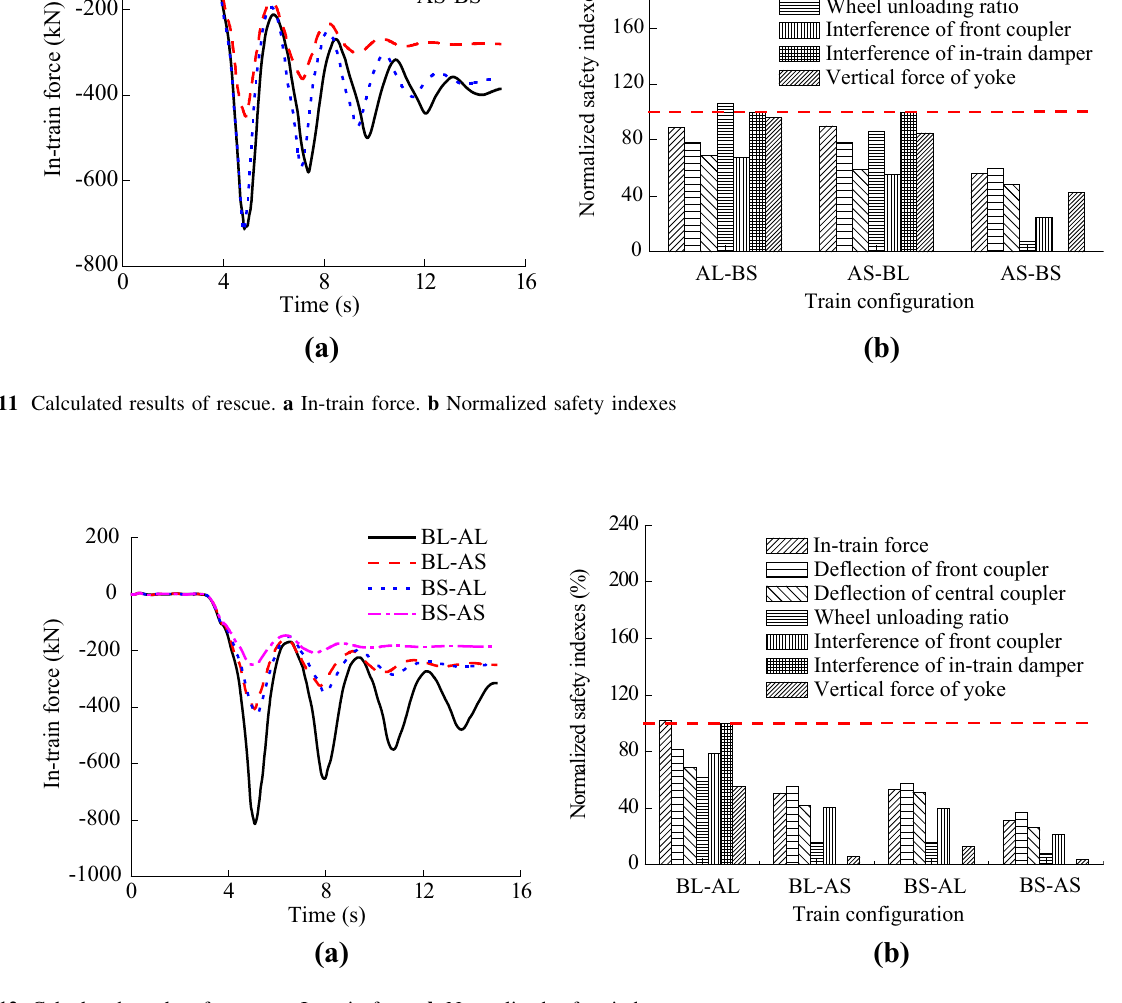
Fig. 12 Calculated results of rescue. a In-train force. b Normalized safety indexes